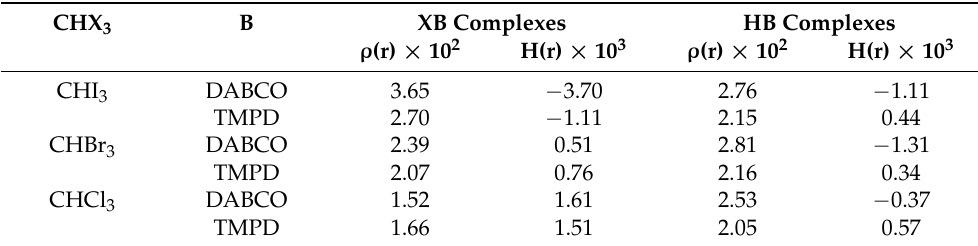
Table 2. Electron densities and energies ( ρ (r) and H(r), in a.u.) at BCPs along XB and HB bond